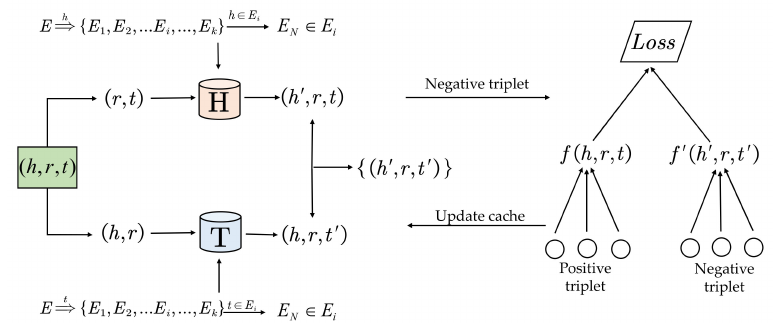
Figure 5. Negative triplet sampling